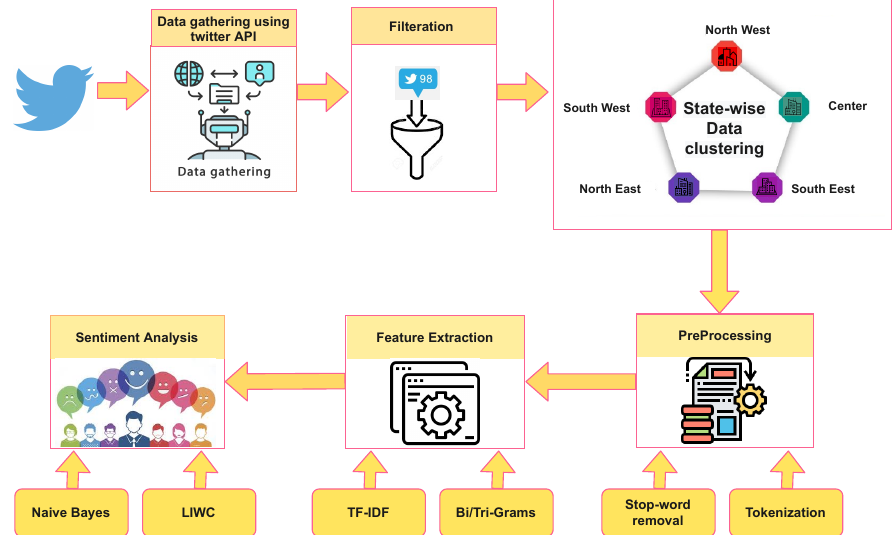
Figure 1. Flow diagram of sentiment analysis on Twitter data.